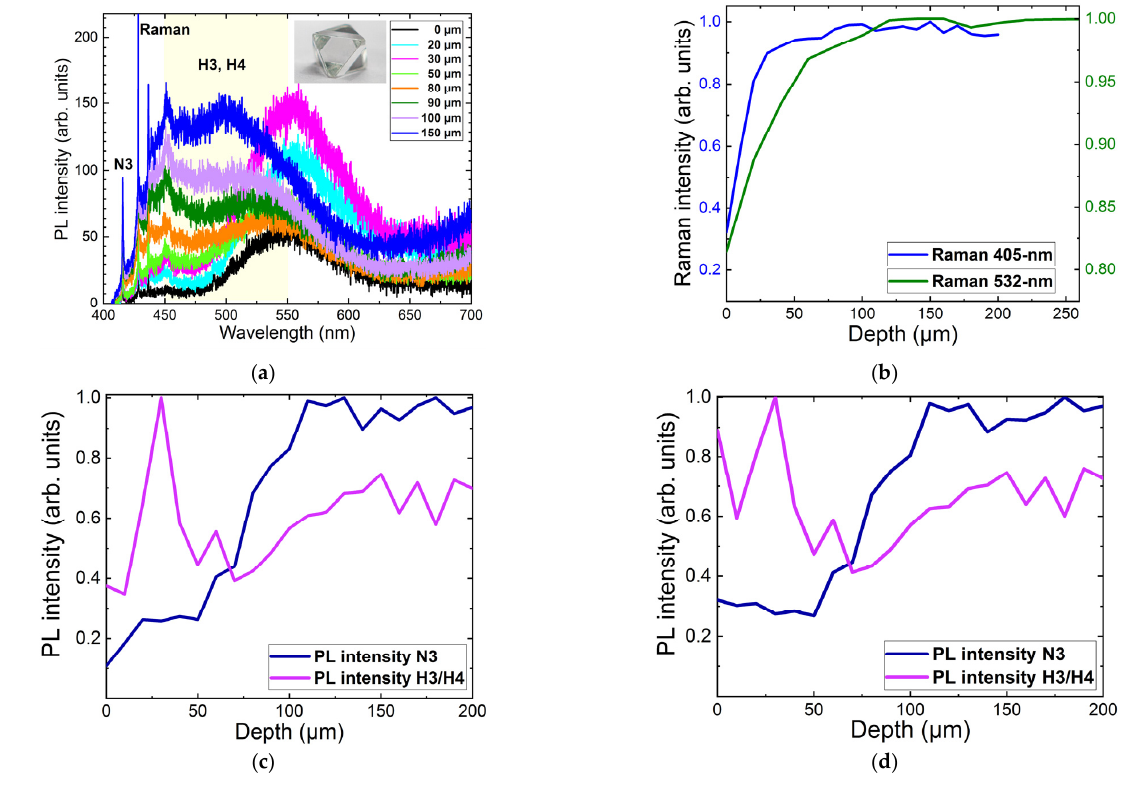
Figure 5. ( a ) PL/Raman spectra of IaAB diamond at different depths (405-nm excitation). Inset: the image of the octahedral diamond; ( b ) Depth dependence of normalized Raman signal excited at 405 and 532 nm; ( c ) Depth dependence of normalized PL yield of N3 (415 nm) and H3/H4 centers, taken at 550 nm, excited at 405 nm; ( d ) Depth dependence of normalized PL yield of N3 (415 nm) centers and H3/H4 (550 nm) centers, excited at 405 nm and corrected for the depth dependence of the Raman signal.